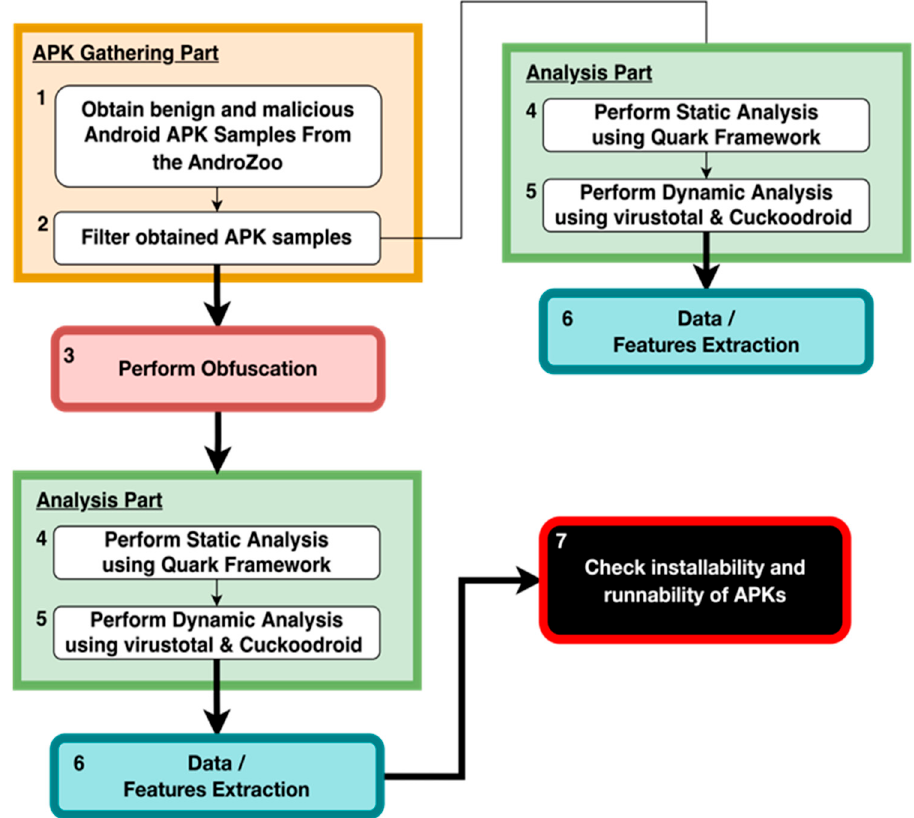
Figure 2. Research Methodology.